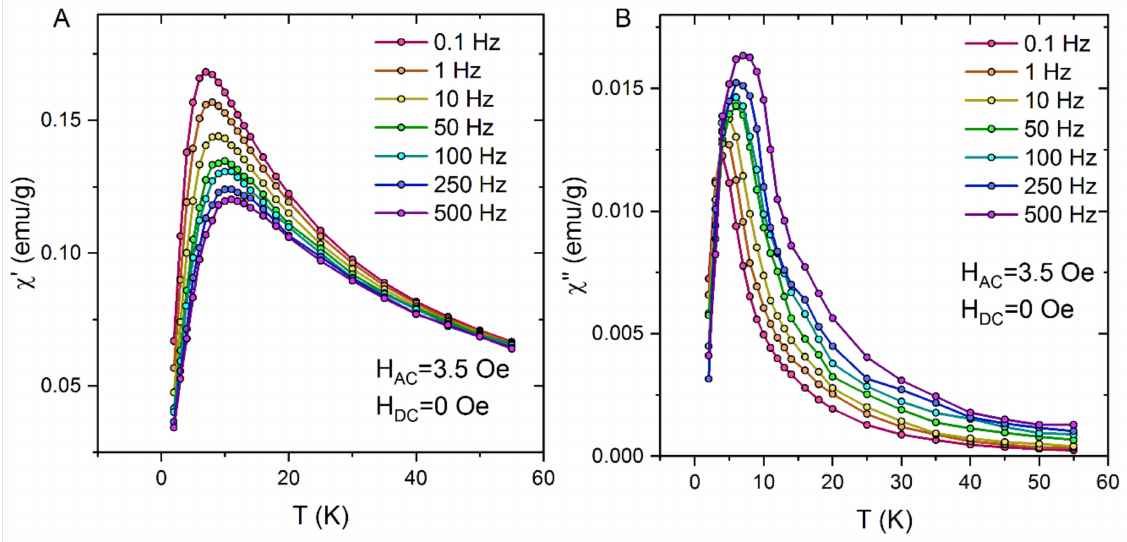
Figure 8. Real ( A ) and imaginary ( B ) AC susceptibility data for PCL fibres with magnetite contents of 2%.